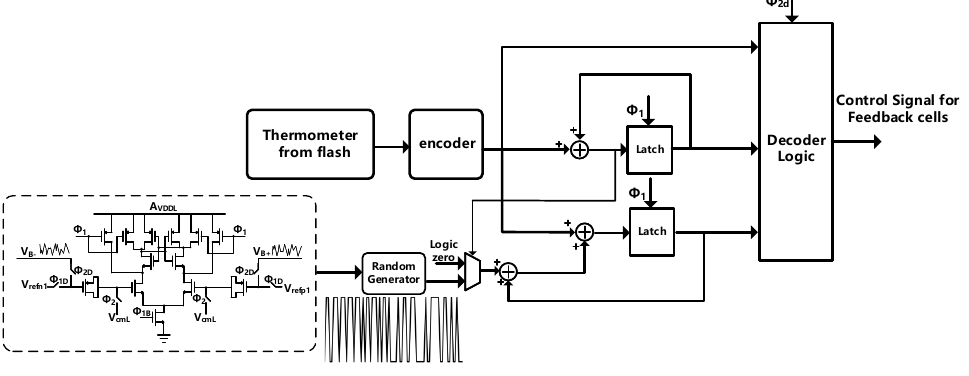
Figure 12. The structure of RnDWA module.